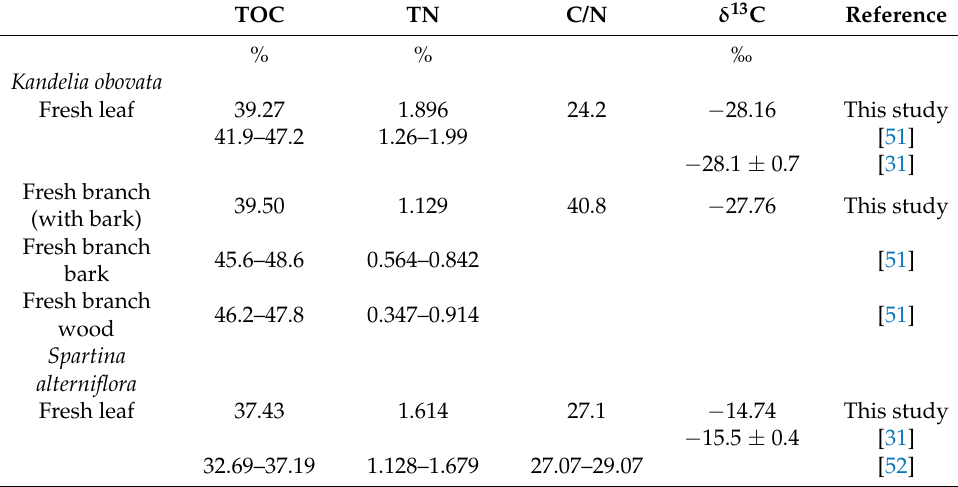
Table 1. TOC, TN, C/N and δ 13 C of plant